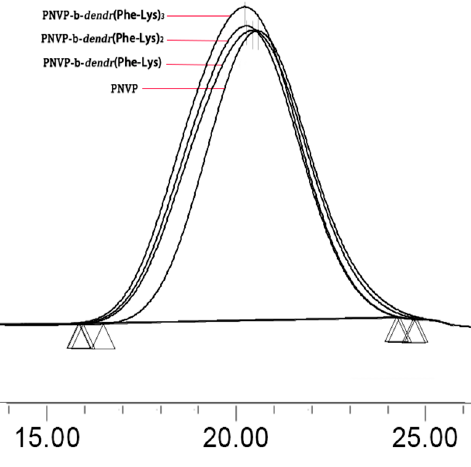
Figure 2. GPC traces of polymers.